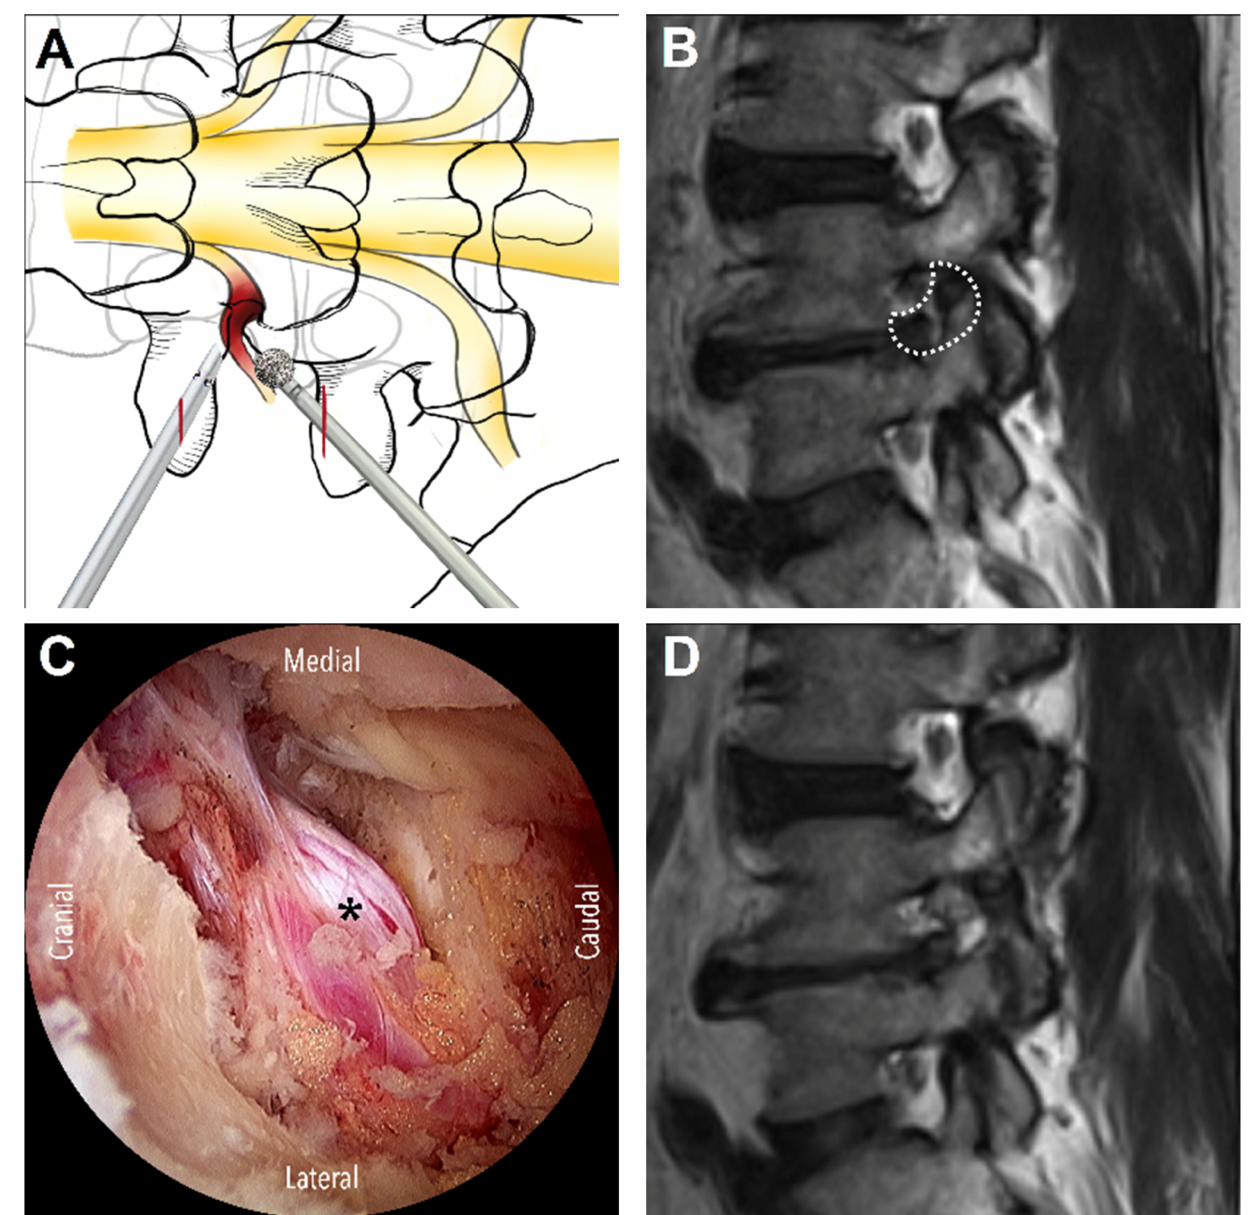
Figure 3. The paraspinal approach. ( A ) The schematic diagram illustrates the skin incisions (red lines) and initial target area of decompression from the left side: the isthmus of pars interarticularis or the tip of superior articular process. ( B ) Pre-operative MRI shows the foraminal stenosis, entrapment of the nerve root, and planned foraminal decompression (dashed line area). ( C ) The endoscopic view demonstrates decompression of the foramen and the exiting nerve root (asterisk). ( D ) Post-operative MRI shows widening of the foraminal space for the nerve